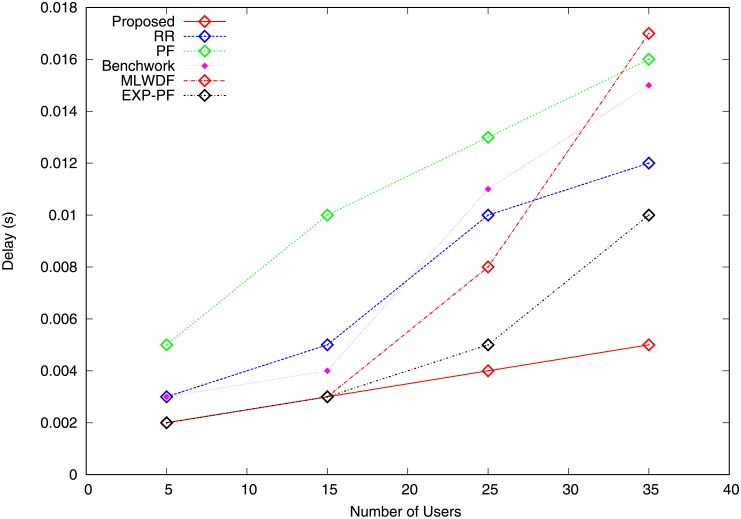
Delay VoIP traffic.